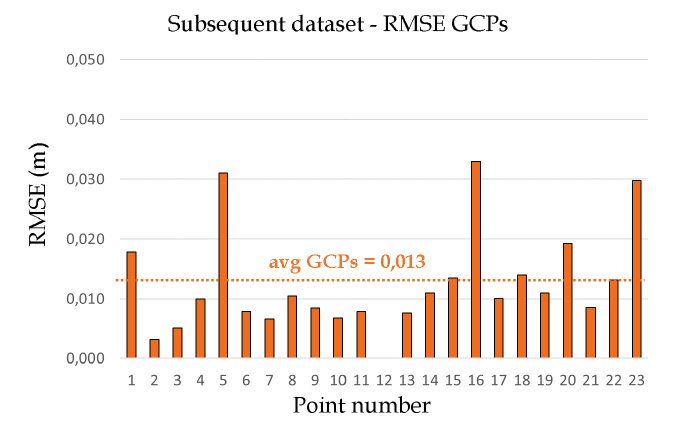
Figure 8. Subsequent datasets—RMSE of the ground control points (indicated in five images for checking purposes only) in the subsequent dataset processed with the reference